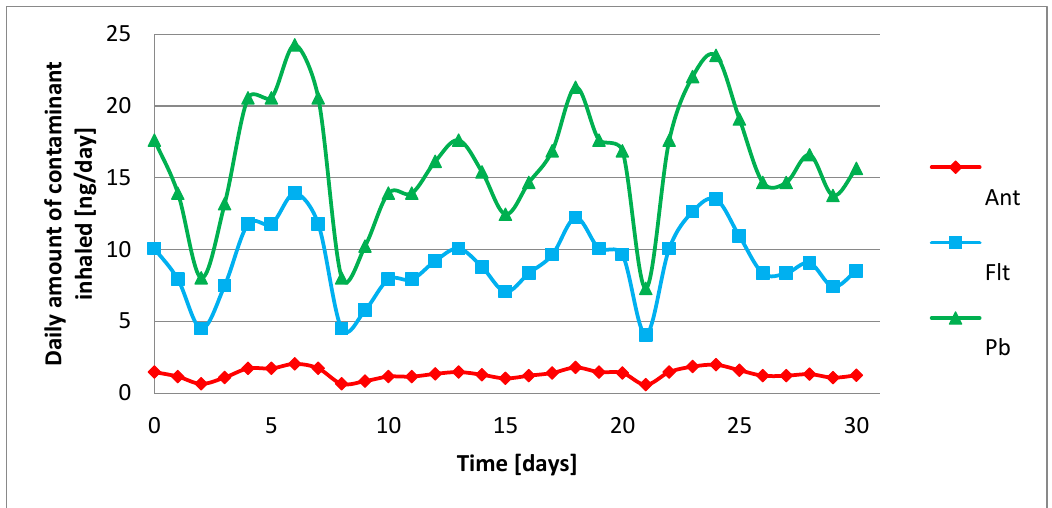
Figure 7. Amount of contaminants inhaled by subject 1.